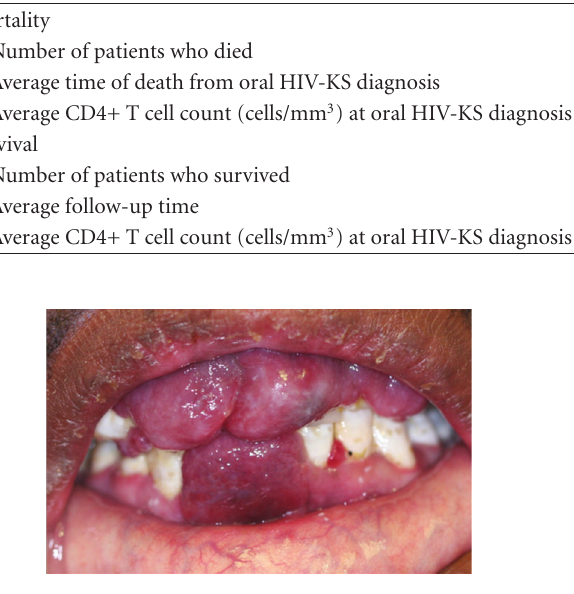
Figure 1: Exophytic oral HIV-KS lesions on the anterior maxillary and mandibular buccal gingiva of a 31-year-old male with a CD4+ T-cell count of 5cells/mm 3 .